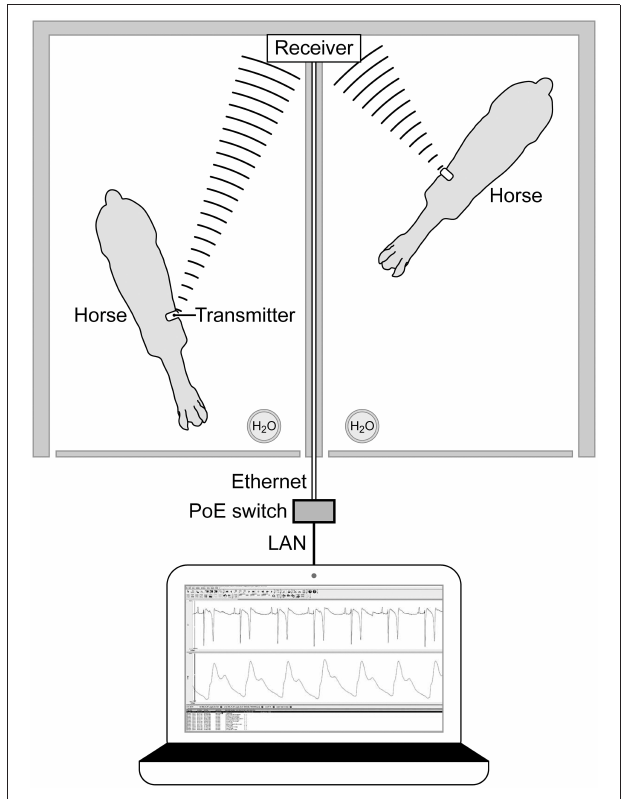
FIGURE 2 | Overhead diagram horses and Bluetooth receiver mounted on the top of the stall wall with Ethernet connection to computer for acquisition of signals. Bluetooth receiver collects signals from the base pack wireless transmitter on the withers of each